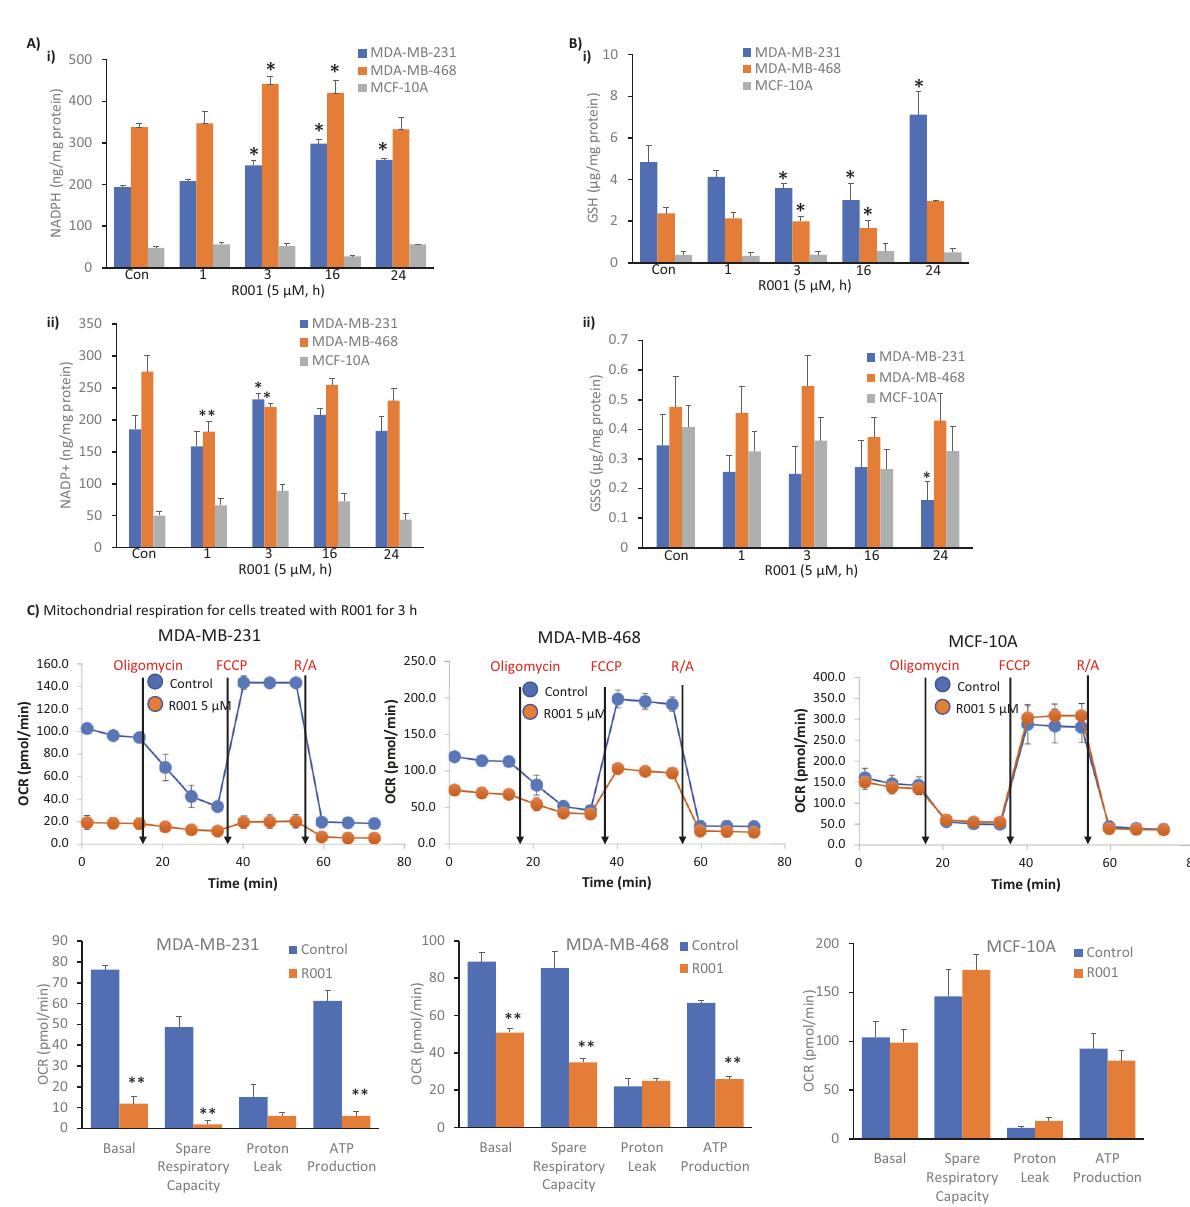
Fig. 3 Effects of R001 on the cellular production of NADPH and GSH and mitochondrial functions. A , B Breast cancer, MDA-MB-231 and MDA-MB-468 cells or normal human breast epithelial, MCF-10A line in culture were untreated (Con) or treated once with 5 µM R001 for the indicated times and cell lysates were prepared and assayed for A NADPH (i) and NADP + (ii), or B GSH (i) and GSSG (ii), which are plotted against treatment time; n = 3; and C Seahorse analysis for mitochondrial respiration performed on live MDA-MB-231, MDA-MB-468, or MCF-10A lines untreated or treated with 5 µM R001 for 3 h and measured as cellular oxygen consumption rate (OCR) at basal condition and after injection of optimal concentrations of oligomycin, carbonyl cyanide-p-tri fl uoromethoxy-phenyl-hydrazone (FCCP), and Rotenone plus Antimycin A (R/A), and plotted as line tracing (upper) and bar graph (lower) showing the different phases. Control lane (Control, Con, 0) represents 0.1% DMSO- treated cells; n = 3. Values, mean ± S.D. * p < 0.05 and ** p < the addition of exogenous anti-oxidant agents. Furthermore, the lack of notable changes in the NADPH, GSH and ROS levels in MCF-10A cells by the R001 treatment indicates that normal cells are resistant to the effects of R001, which is consistent with the weak effects on the proliferation of the normal cells (Fig. 1B, MCF-10A).